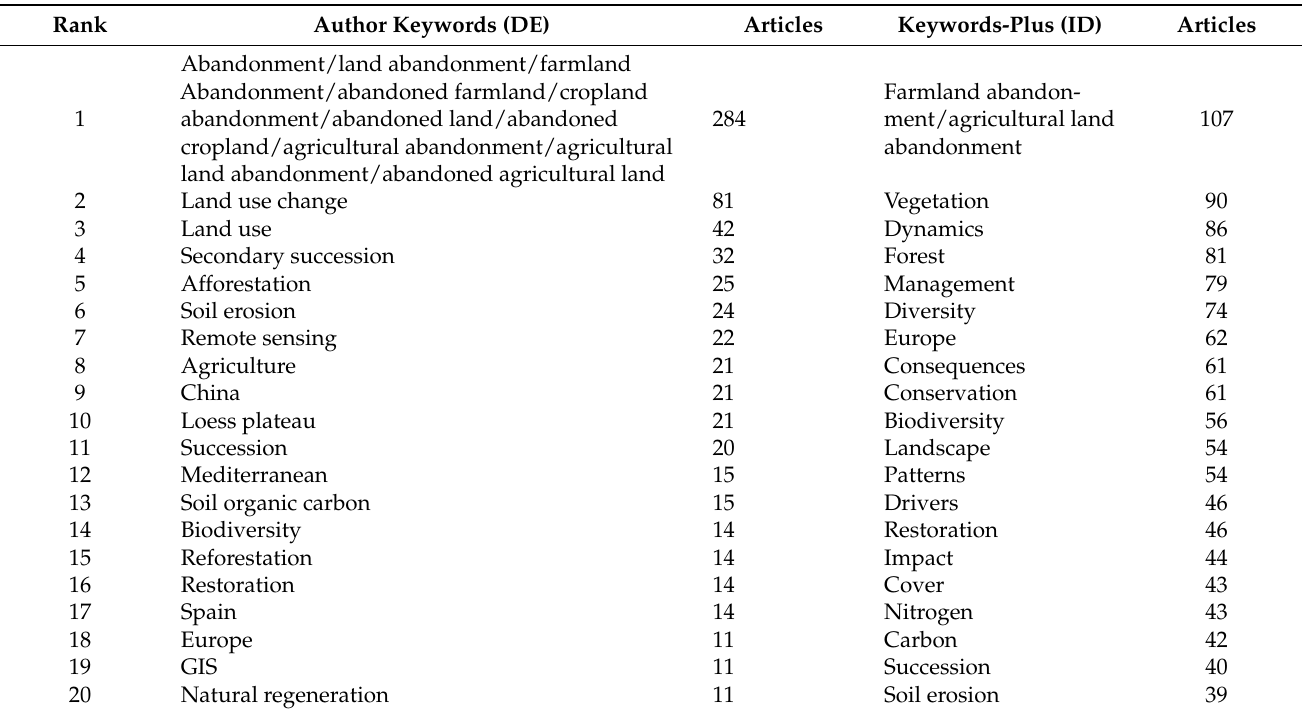
Figure A3. Strategic coordinates of the farmland abandonment period 1980–2000 ( A ), 2001–2015 ( B ), and 2016–2021 ( C ). Table A1. Most relevant keywords when searching for publications in farmland abandonment from 1980 to 2021.